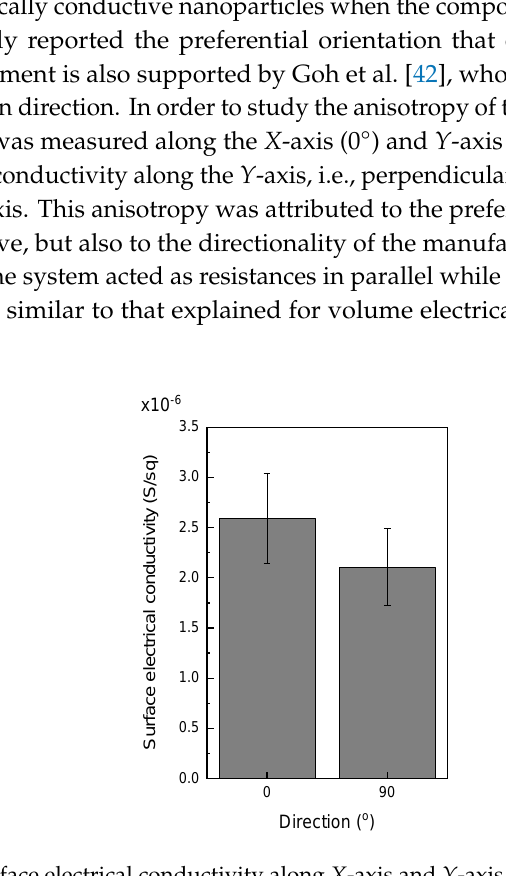
Figure 8. Surface electrical conductivity along X -axis and Y -axis of P3.4 printed parts.